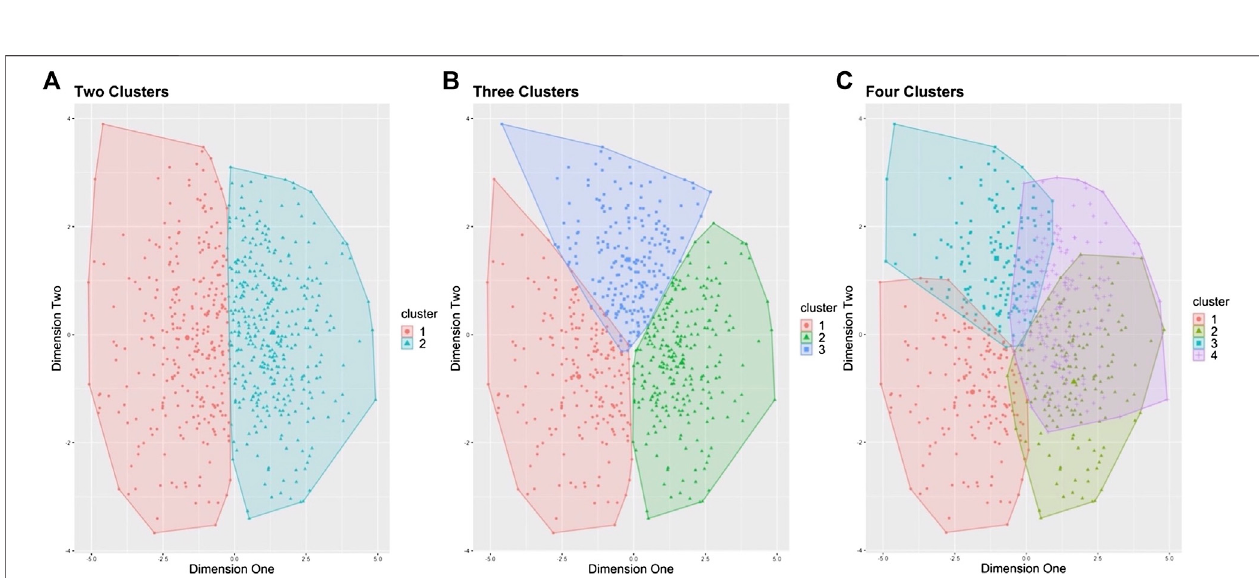
FIGURE4| Threeseparateanalysesofk-meansclustering(k=2,3,and4). (A) k=2, TwoClusters . (B) k=3, ThreeClusters . (C) k=4, FourClusters ;Represented by PCA 2-d plot for representation of cluster distribution and overlap; (B) was chosen with insight from elbow plot, and visual comparison of cluster distributions with minimal overlap of